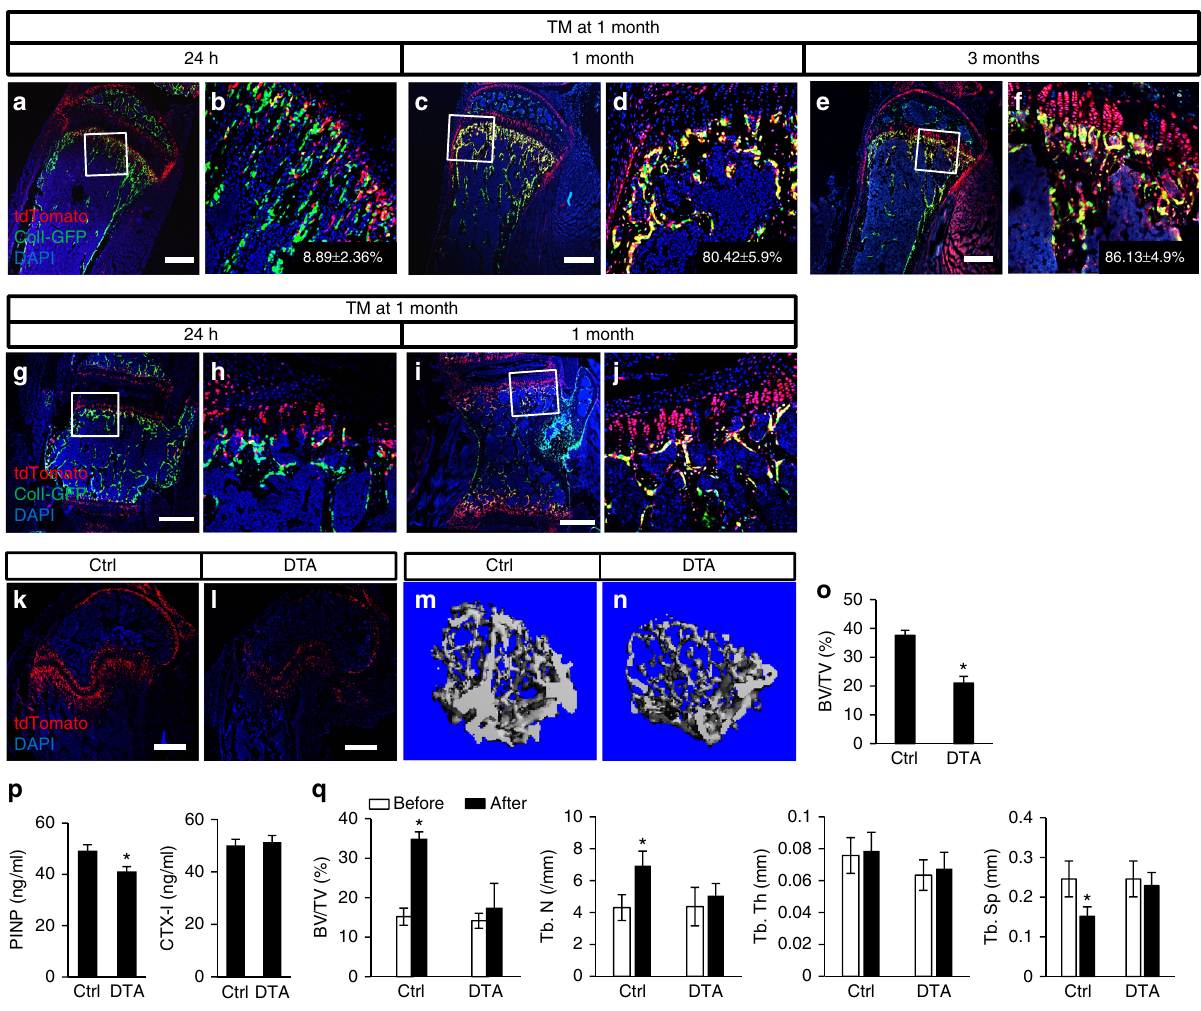
Fig. 3 Gli1 + cells are critical for cancellous bone formation in postnatal mice. a – j Postnatal Gli1 + cells produce osteoblasts. Gli1-CreER T2 ; Ai9; ColI-GFP mice were treated with TM at 1 month of age and analyzed at 24 h a , b , g , h ; 1 month c , d , i , j ; or 3 months e , f after the last TM dosing. Representative confocal images are shown for tibia a – f and lumbar vertebrae g – j . Boxed areas are shown at a higher magni fi cation in corresponding panels to the right. Percentage (mean ± SD, n = 3) of tdTomato + GFP + over total GFP + cells a – f was calculated from cancellous bone region extending 300 µ m from growth plate on two sections each of three mice. Scale bar: 500 µ m. k – q Postnatal Gli1 + cells are necessary for cancellous bone formation. DTA (Gli1-CreER T2 ; Ai9; Rosa-DTA) or Ctrl (Gli1-CreER T2 ; Ai9) littermates were treated with TM once daily for 3 consecutive days starting at 1 month of age and harvested at 3 weeks after last dosing. k , l Loss of tdTomato + cells in the distal femur of DTA ( l ) compared to Ctrl mice ( k ) at the time of harvest. Scale bar: 500 µ m. m , n Representative μ CT images from cancellous bone of distal femur. o Quanti fi cation of cancelluous bone mass (BV/TV) by µ CT in distal femur. p Serum levels of P1NP (left) and CTX-I (right) at the time of harvest. q In vivo microCT analyses of cancellous bone parameters in distal femur of mice immediately before TM (white bar, “ Before ” ) or immediately before harvest (black bar, “ After ” ). BV/TV bone volume over tissue volume, Tb.N trabeculae number, Tb.Th trabeculae thickness, Tb.Sp trabeculae spacing. n = 3, * p < 0.05, paired Student's t